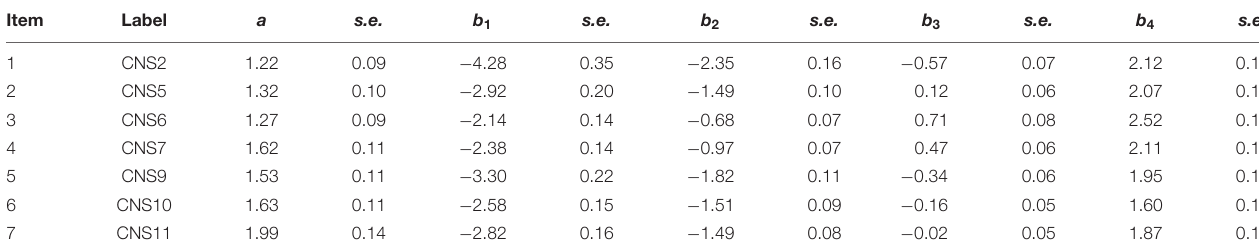
TABLE 4 | Estimates of the parameters of the items of the graded response